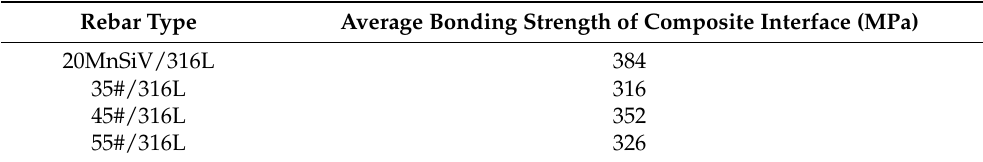
Table 6. Test results of bonding performance of various rebar composite